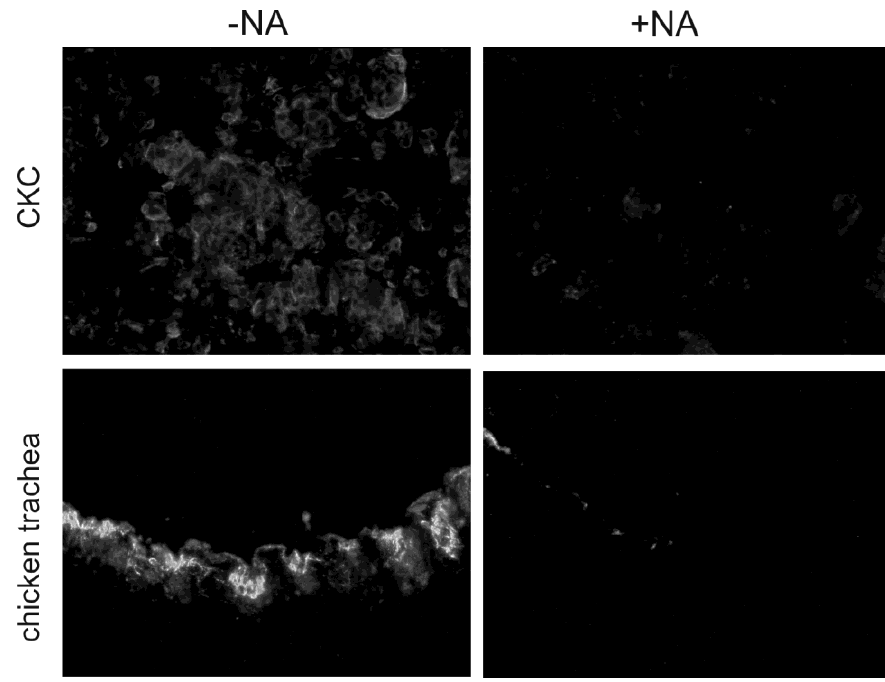
Figure 6. Sialic acid dependent binding of soluble IBV spike proteins to IBV-susceptible chicken cells: primary chicken embryo kidney cells (CKC) and cryosections of chicken